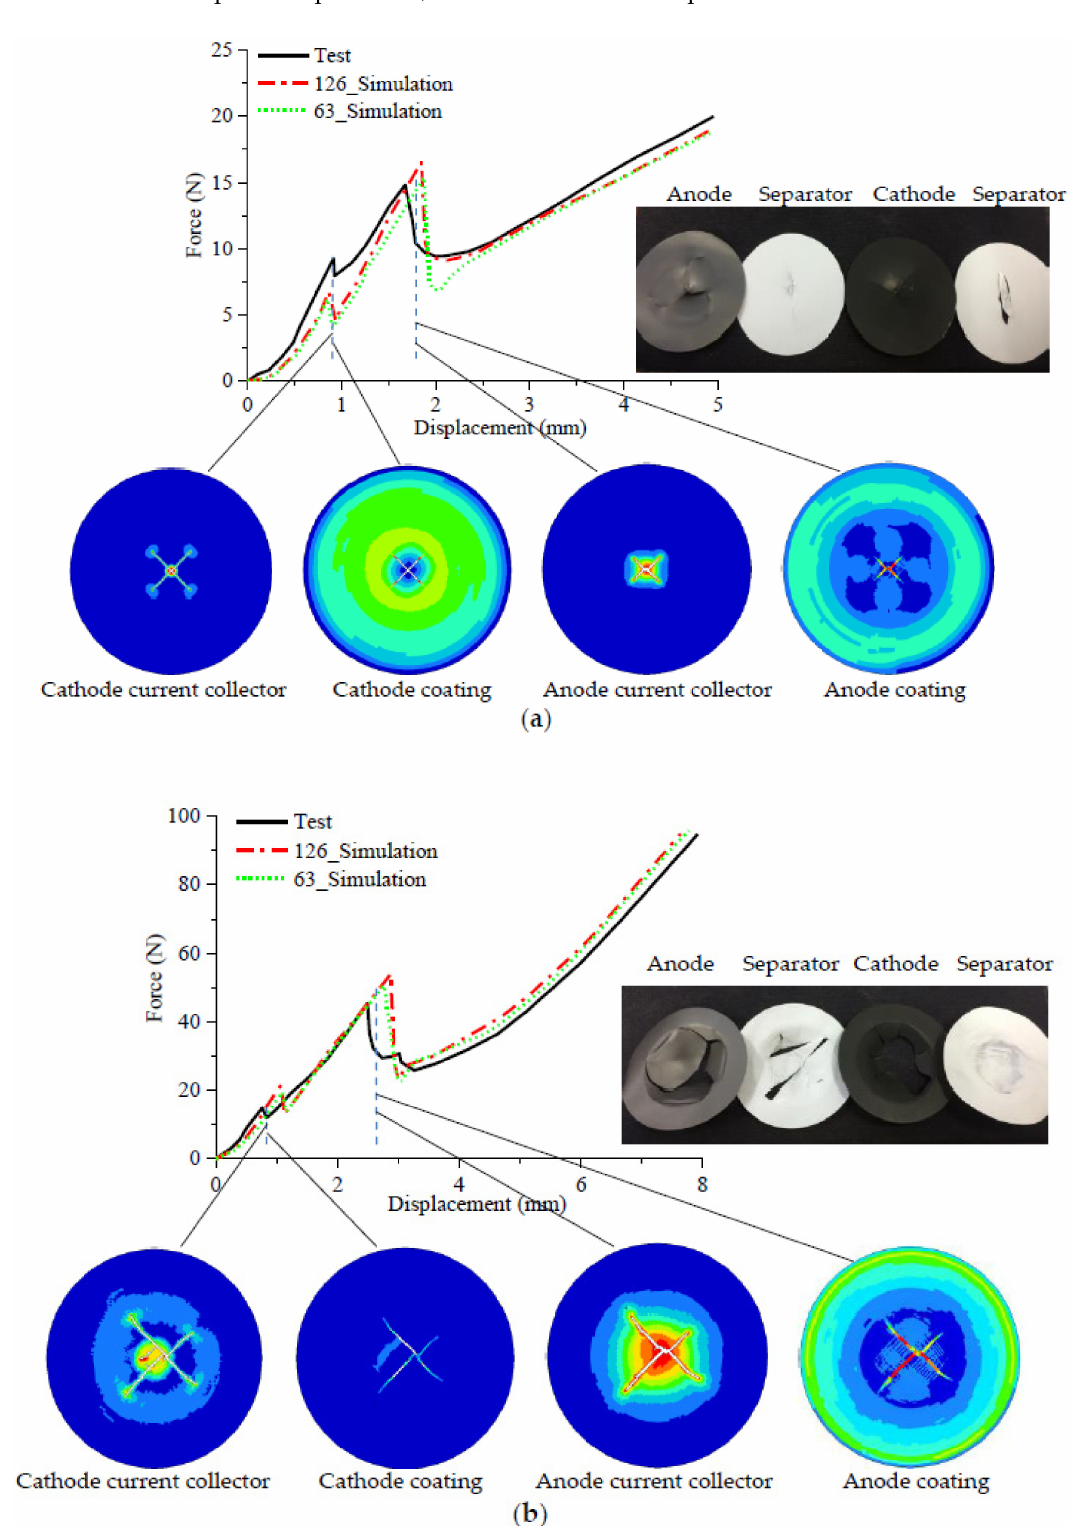
Figure 11. Force-displacement curves of a layer element under spherical punch: ( a ) Comparison of test and simulation curves under Φ 6.3-mm spherical punch; ( b ) Comparison of test and simulation curves under Φ 25 mm spherical